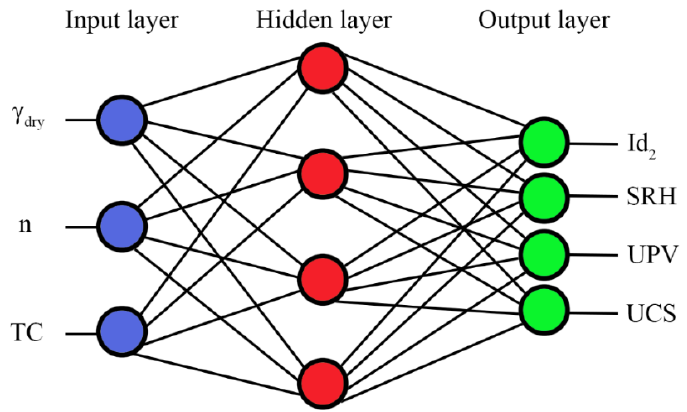
Figure 11. Schematic representation of the constructed neural